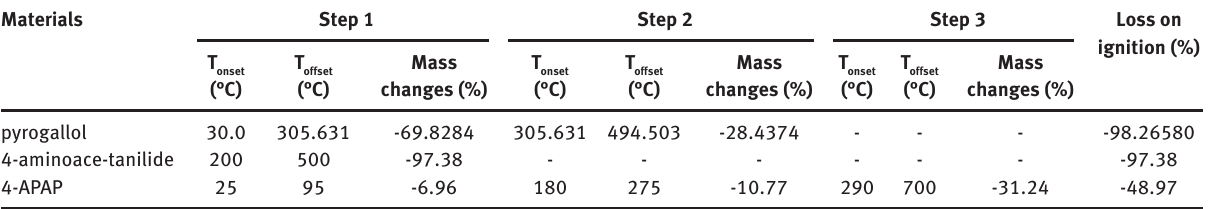
Table 2: Effect of temperature on DSC curves of materials Materials